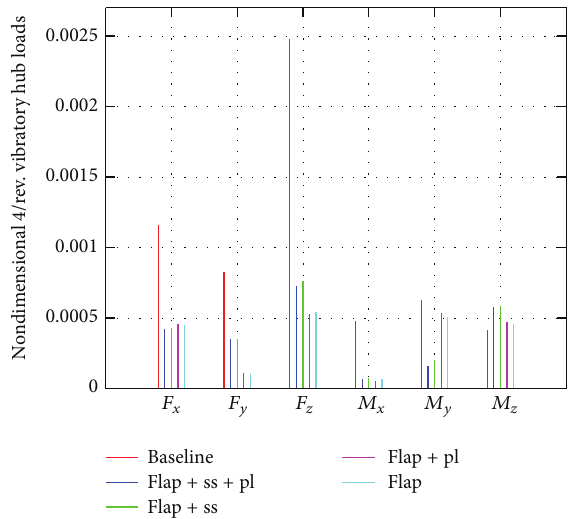
Figure 9: Hub loads with feedback, Drees synthesis, and free-wake inflow validation.